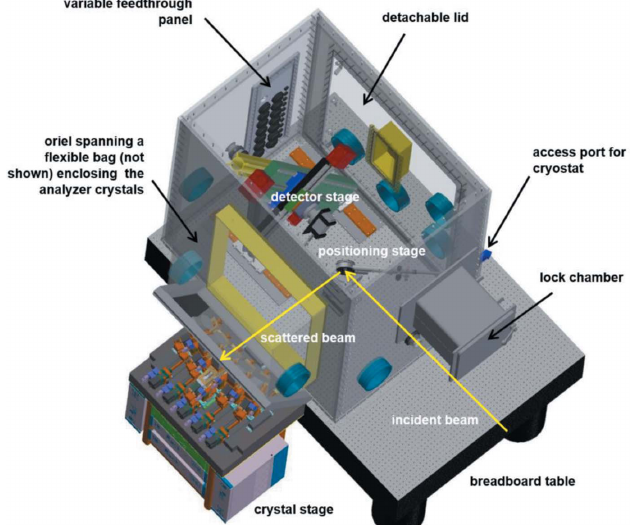
Figure 2 A 3D CAD model of the He box, providing an improved concept with possibilities for several experiments, e.g. enabling in situ measurements and cryostat experiments at the M -edges of actinides at the ACT